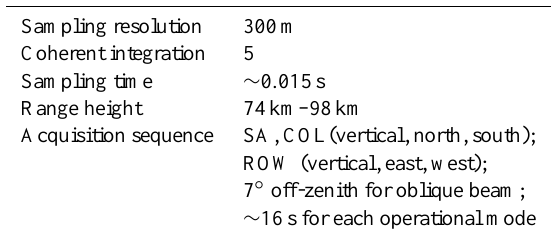
Fig. 1. Configuration of OSWIN VHF radar (54.1 ◦ N and 11.8 ◦ E). The antenna array consists of 144 Yagi antennas (presented by short-slash lines) and can be divided into six subarrays (24 Yagis for each) for transmission and reception of SA and DBS observa- tions. The DBS operation contains two modes: COL and ROW. The antennas in each subarray are arranged as 6 × 4, 12 × 2, and 2 × 12 for the SA, COL, and ROW modes. Table 1. Radar parameters used in observation.